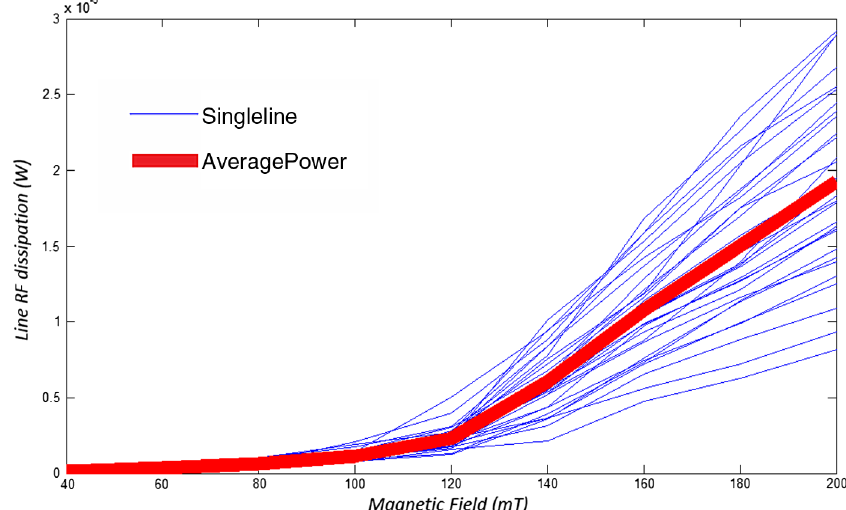
FIG. 14. Calculated rf power dissipation on each representative 3 . 125 μ m wide strip as a function of external applied magnetic H fi eld for a 100 μ m × 100 μ m BCP-treated fine grain Nb surface. Blue lines are the rf loss from each of 32 strips and the red line is the averaged rf loss.